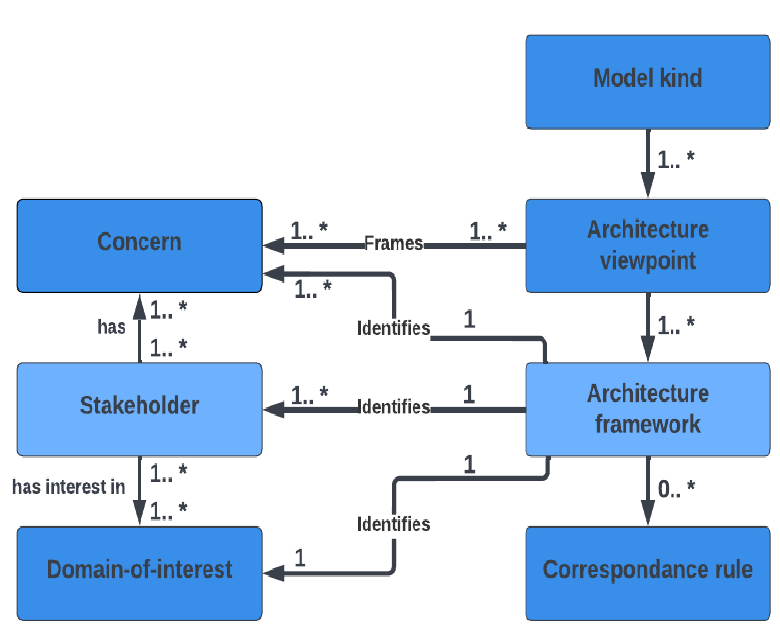
Figure 14. Conceptual model of an architectural framework of P2413 standard (based on ISO/IEC/IEEE 42010:2011) [72].